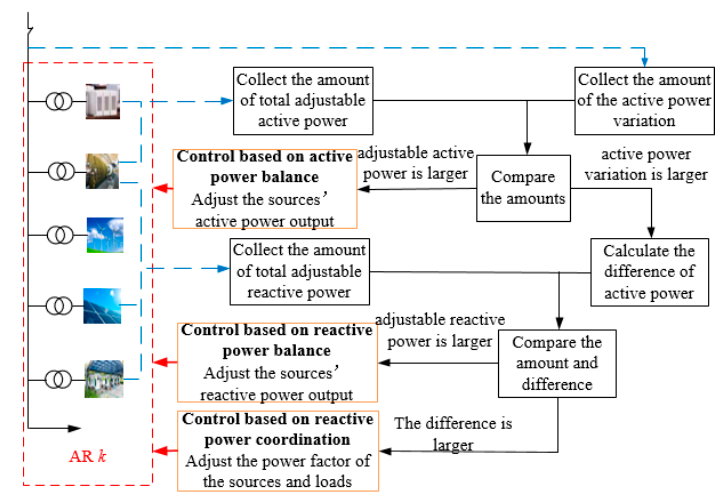
Figure 3. Principle of voltage control based on regional power coordination.